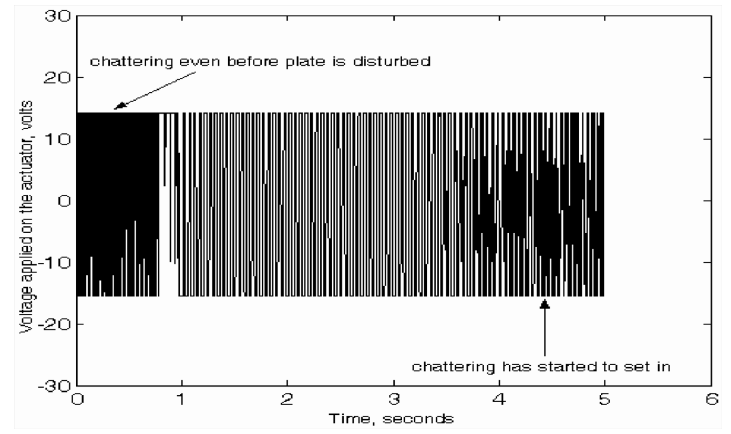
Fig. 11. Voltages applied on actuator when plate is controlled by SMC without boundary layer.